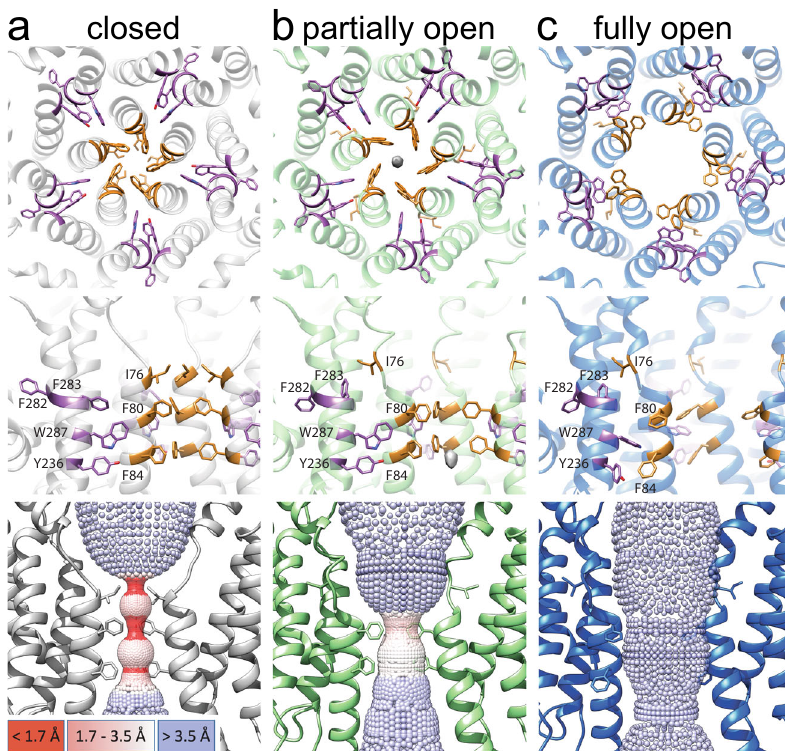
Fig. 2 Different conformations of the neck. a Molecular model of the bottom (top row) and side (middle row) views of the neck in the Ca 2 + -bound closed state (hBest1). The neck residues (I76, F80, F84) and critical residues involved in neck gating (Y236, F282, F283, W287) are labeled. Bottom row, closed state model with pore diameter depicted as colored dots. Tighter pore radius has smaller, denser, red dots, while a less restrictive radius has larger, less dense, blue dots. Inset , color key. b Models for the Ca 2 + -bound partially open state (hBest1), in the same format as in a . An ion-like density is captured at F84 of the partially open neck in hBest1. Density shown from C1 re fi nement. c Models for the Ca 2 + -bound fully open state (hBest2), in the same format as in a